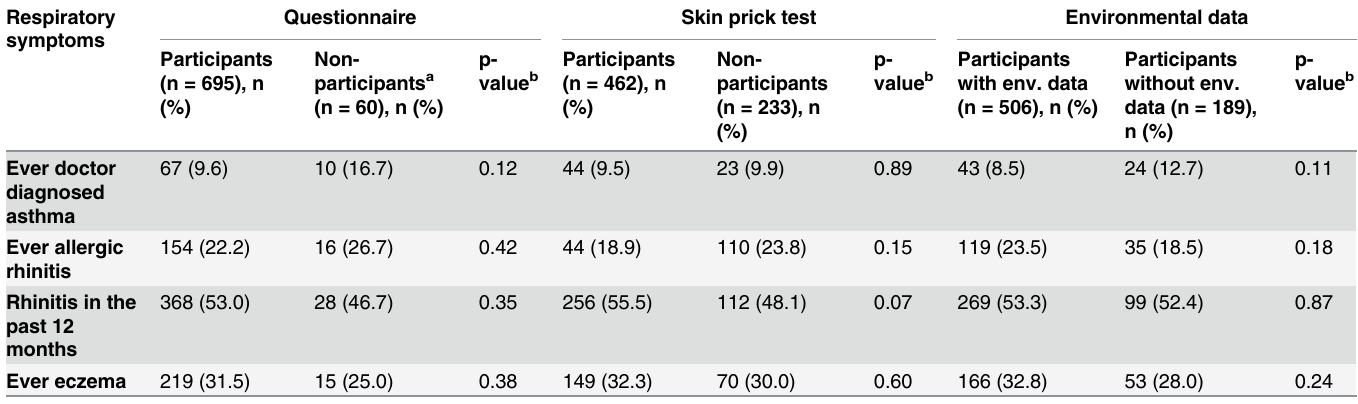
Table 2. Comparison of asthma, rhinitis and eczema among participants and non-participants.